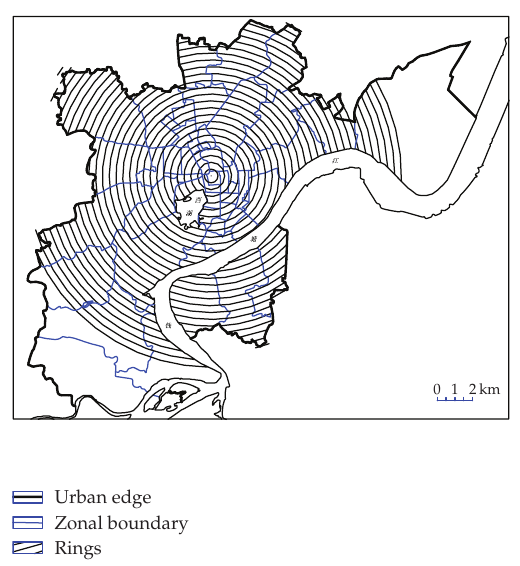
Figure 2: Study area and zonal system in the Hangzhou metropolis (cid:6) from Feng (cid:4) 14 (cid:5)(cid:7)